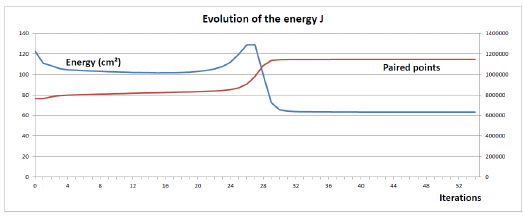
Figure 14: Evolution of the energy for real point cloud